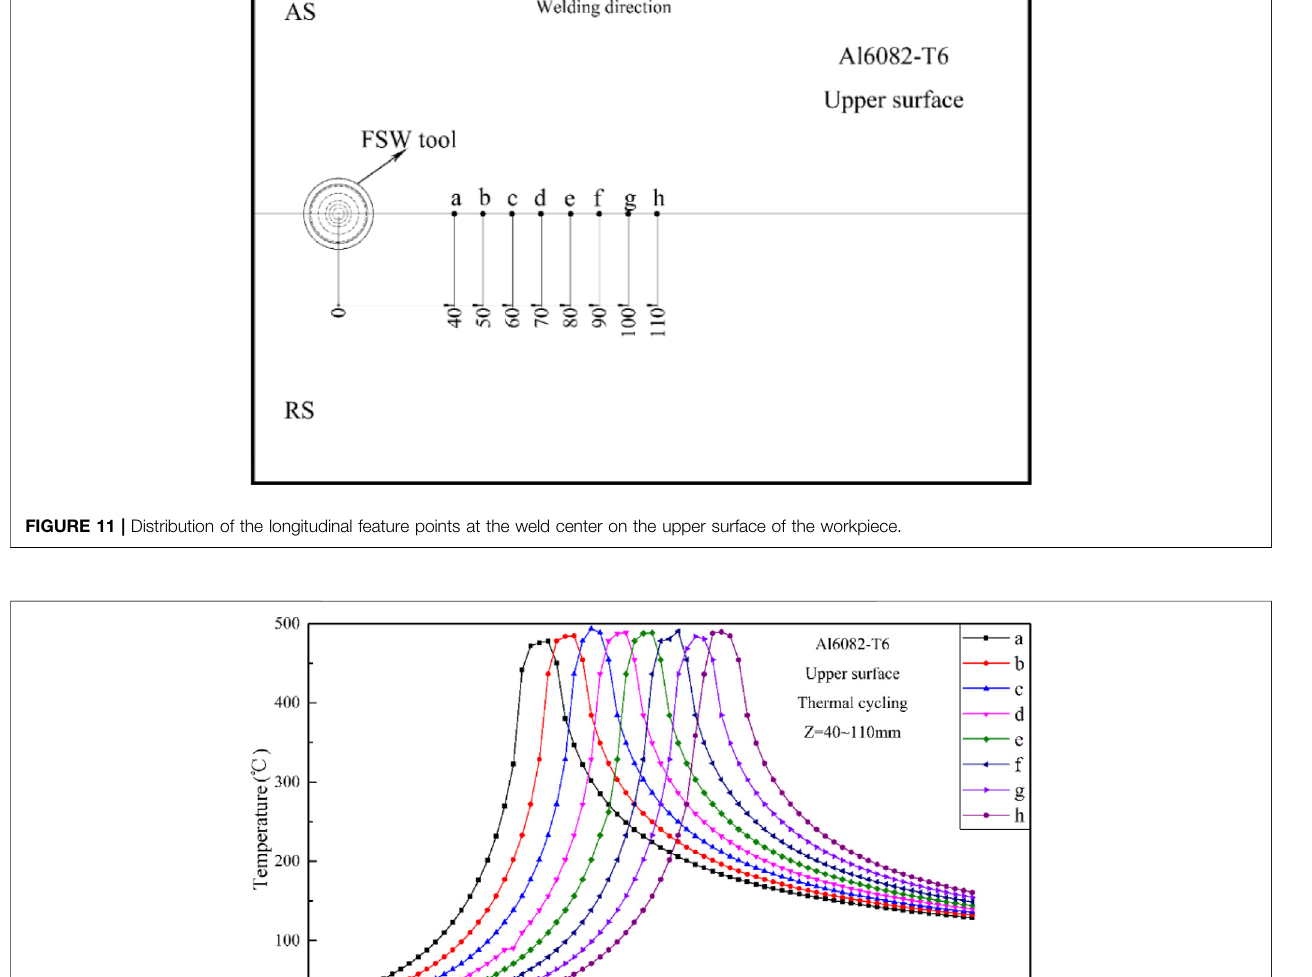
Figure 12 . The thermal cycle experienced by each feature point along the welding direction is basically the same. In the preheating stage before welding, the thermal input generated by the welding tool